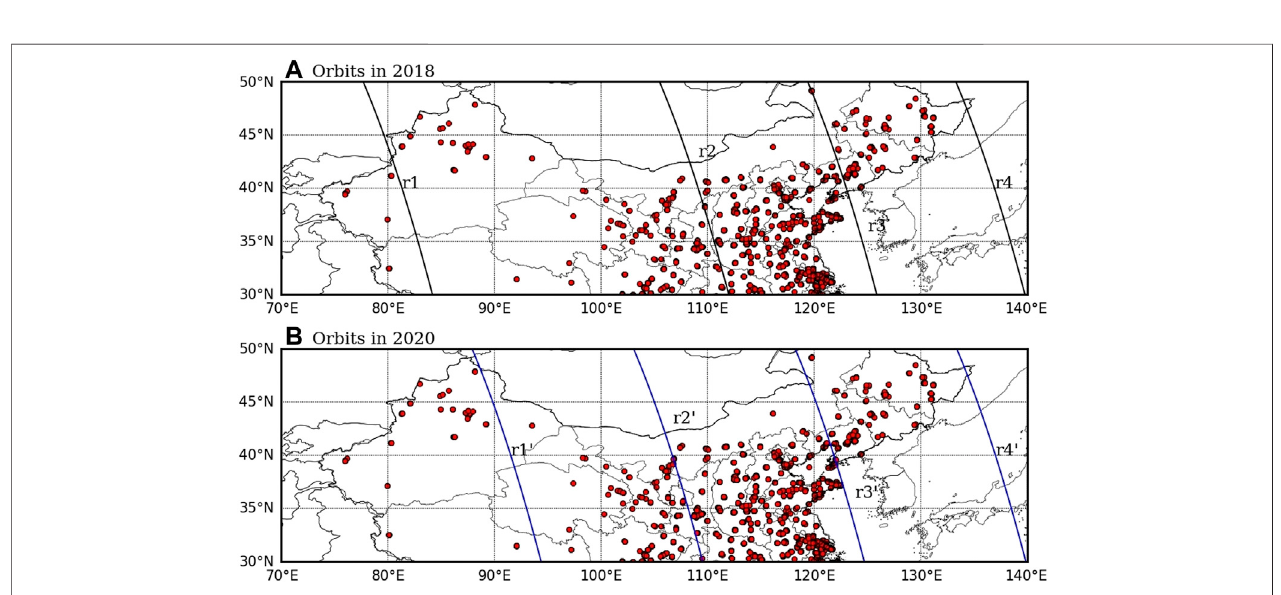
FIGURE 11 | The orbits and the distribution of ground air quality observation sites in 2018 (A) and 2020 (B) .